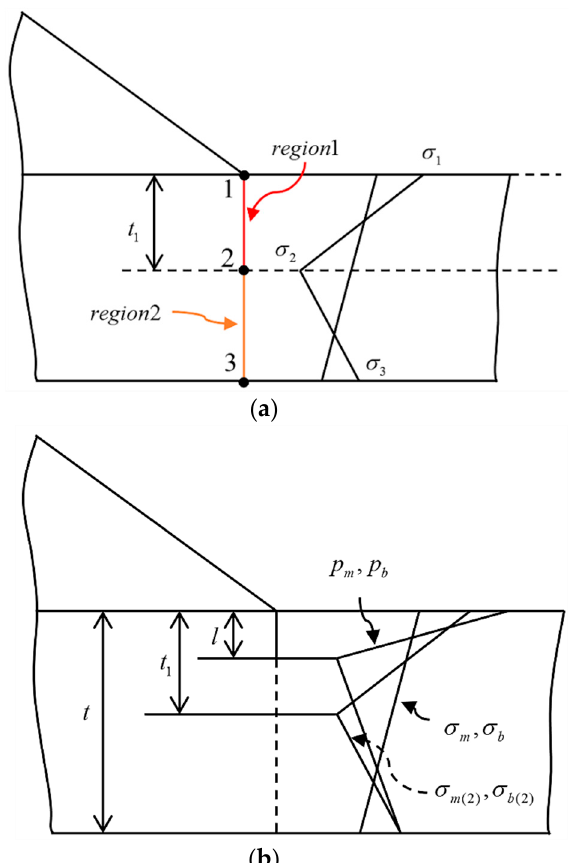
Figure 5. The distributions of notch stresses in terms of p m , p m in Equation (48): ( a ) illustration of considering notch stress distribution as two linear distributions in region 1 and region 2; ( b ) relationship between p m , p m in Equation (48) and σ m ( 2 ) , σ b ( 2 ) , σ m , σ b in Equations (44), (45) and